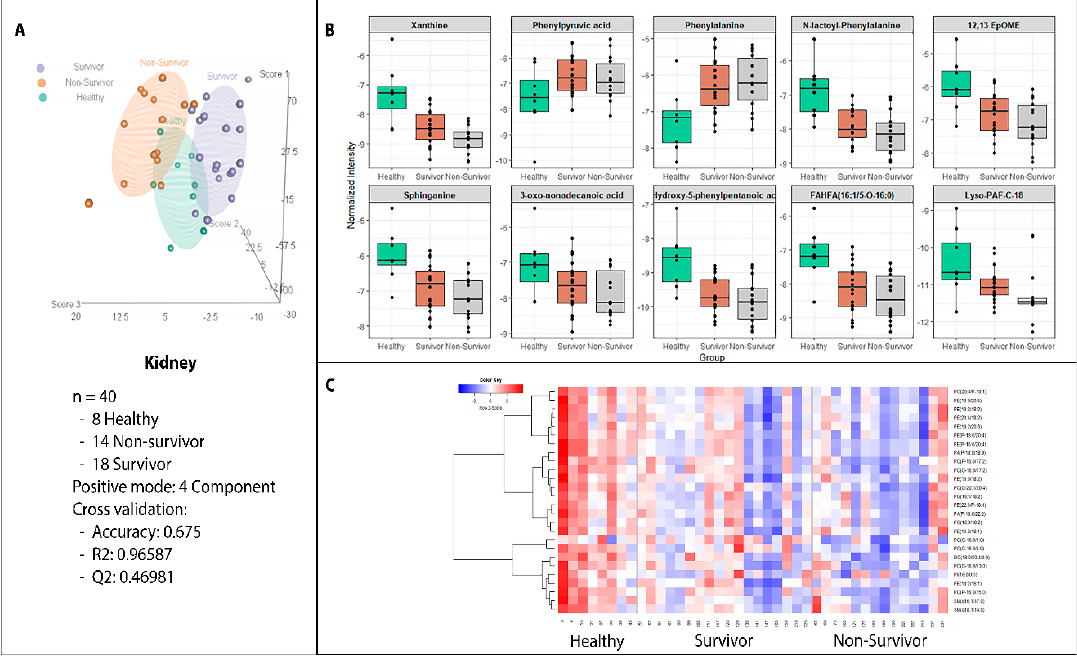
Figure 4. Metabolomic and Lipidomic profiles of kidney in NHPs pre and post-irradiation. Panel A: Three dimensional PLS-DA plot showing separation of healthy NHPs (N = 8) from those who either survived (N = 18) or succumbed to radiation-induced (N = 14) tissue injury within 60 days.Prediction accuracy for 100 permutations yielded a p-value of 0.07. Panels B and C: the relative abundance of significantly dysregulated metabolites and lipids in the threes study groups, respectively.